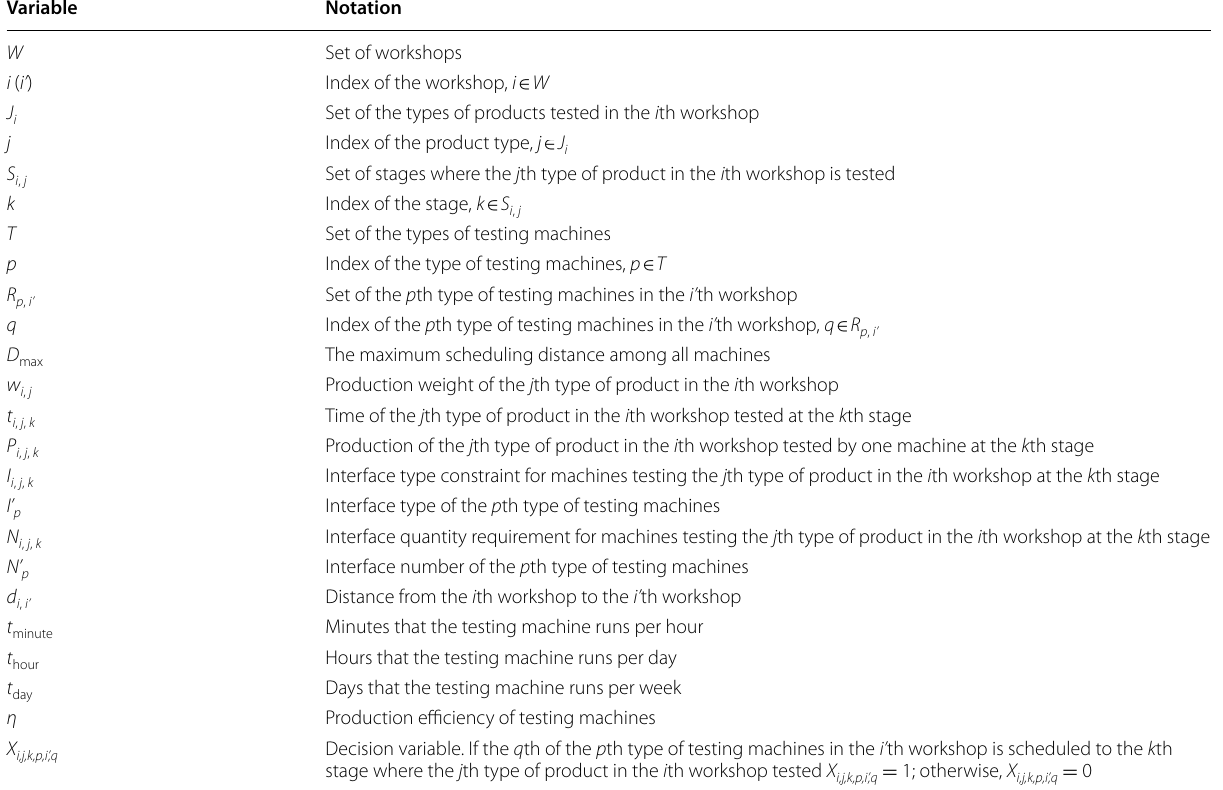
Table 1 Notations and decision variables for the mathematical model of the EDTMAP Variable Notation Set of